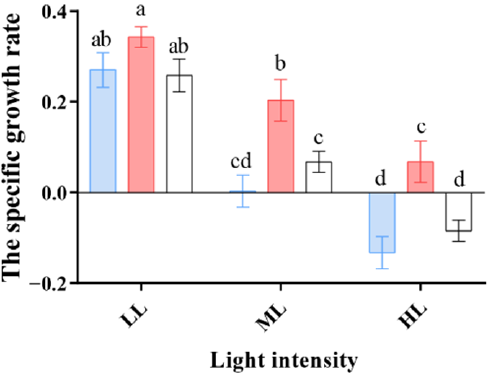
Figure 3. The specific growth rate of H. lacustris under different light conditions with the blue light (blue bar), red light (red bar), and white light (white bar). Light intensities are 18 μ mol/m 2 ·s (LL), 55 μ mol/m 2 ·s (ML), and 110 μ mol/m 2 ·s (LL). Error bars show the standard deviation for three replicates. Different superscript letters indicate significant differences among treatments (two-way ANOVA with Tukey correction, p < 0.05).